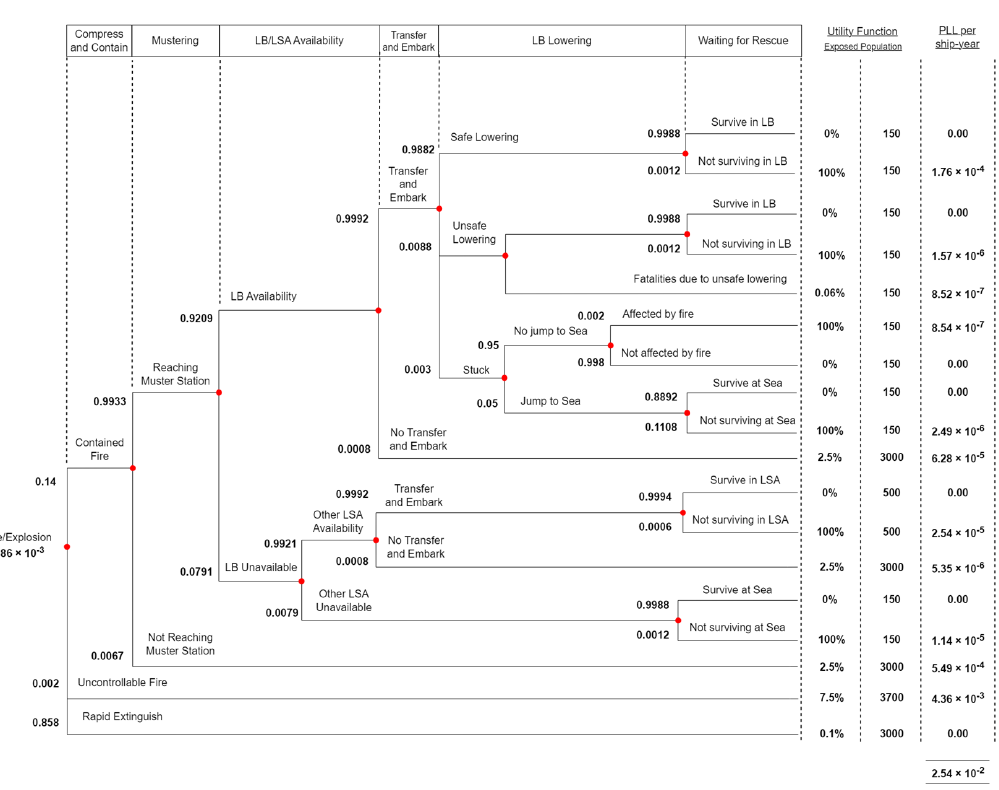
Figure 11. Event tree calculations and results for the baseline scenario of fire/explosion accidents.